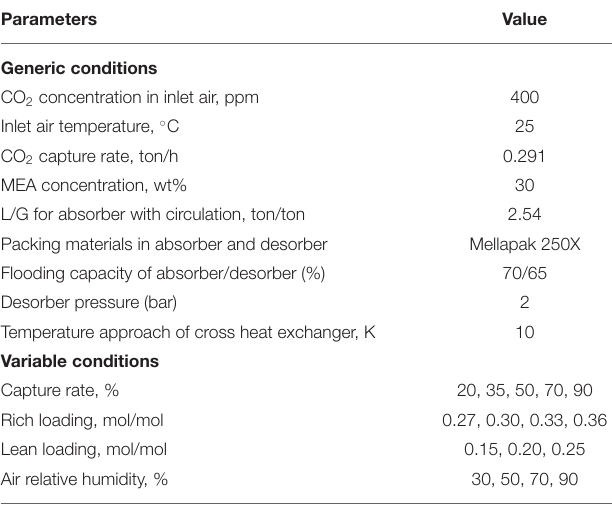
TABLE 2 | Conditions for the MEA-based CO 2 capture process